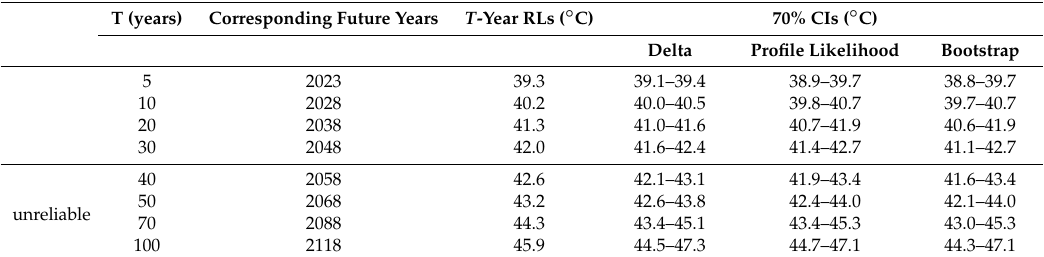
Figure 4. Integrated predictions from 2018 at the Orange Station for three dates: 2017, 2030, and 2050. Confidence intervals (CIs) calculated with the ( Left ) delta, ( Middle ) profile likelihood, and ( Right ) bootstrap methods. Table 3. Results of the integrated predictions (IPs) from